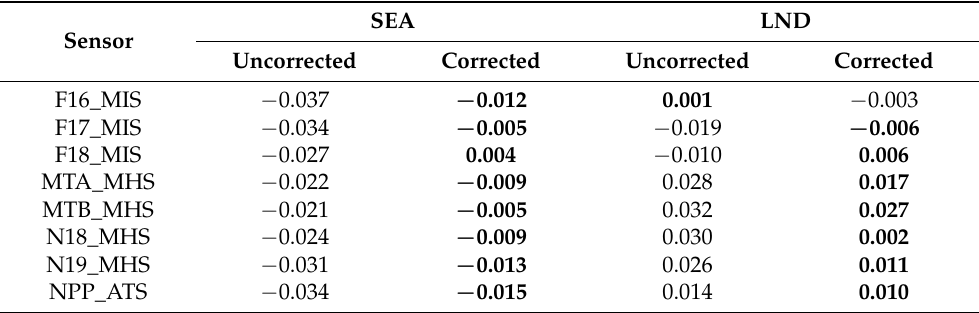
Table 2. MBE scores for target PMW target sensors against COR_GMI in April–October 2014. Bold numbers indicate improved scores (uncorrected) and after (corrected) MMN correction.